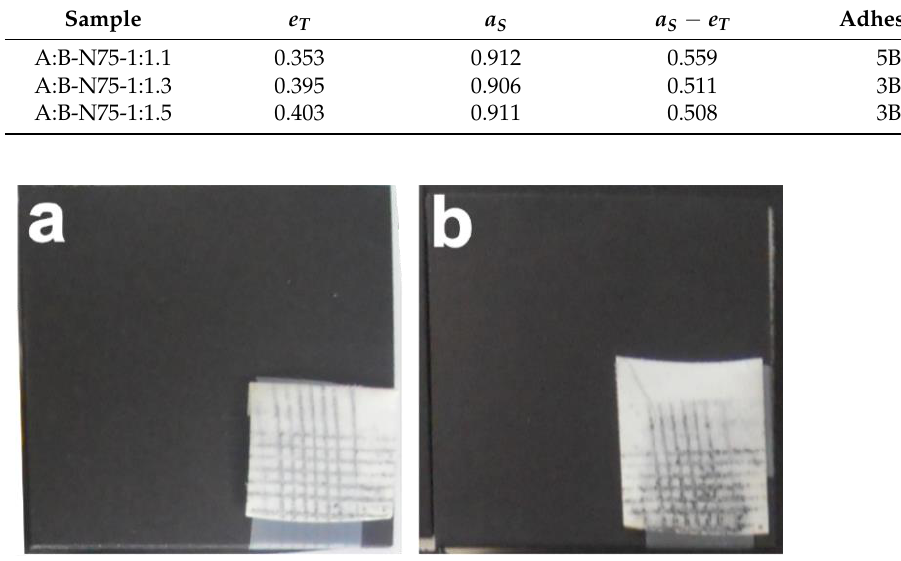
Figure 11. Photograph of cross-cut tests for two TISS coatings onto the polymeric substrate, prepared with the binder L200 and different catalysts: ( a ) Desmodur N75 and ( b ) Desmodur